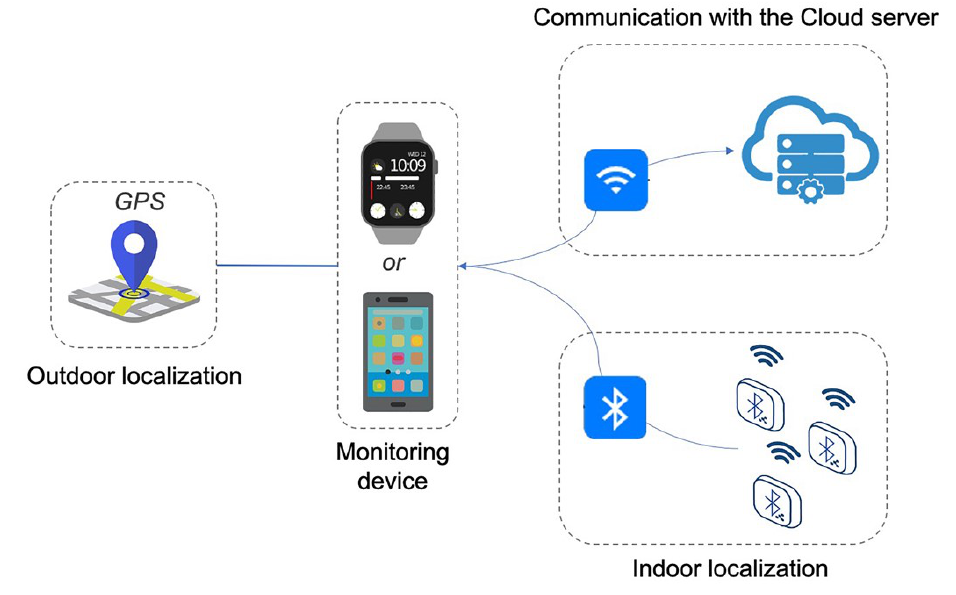
Figure 28. Proposed location